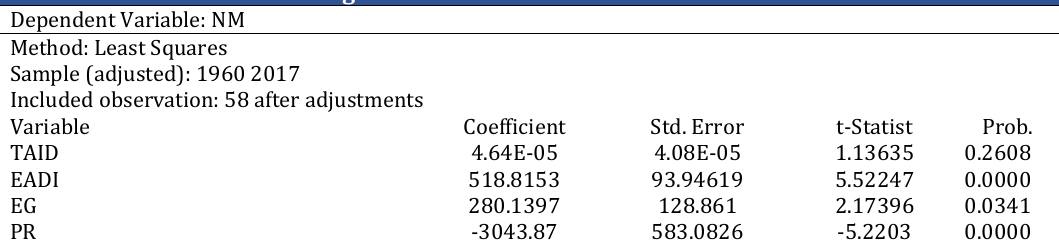
Table 15: Estimation of net migration model Dependent Variable: NM